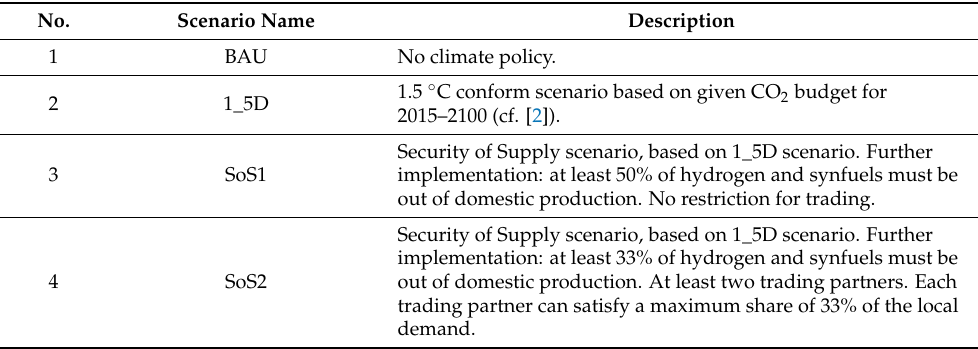
Table 4. Scenario